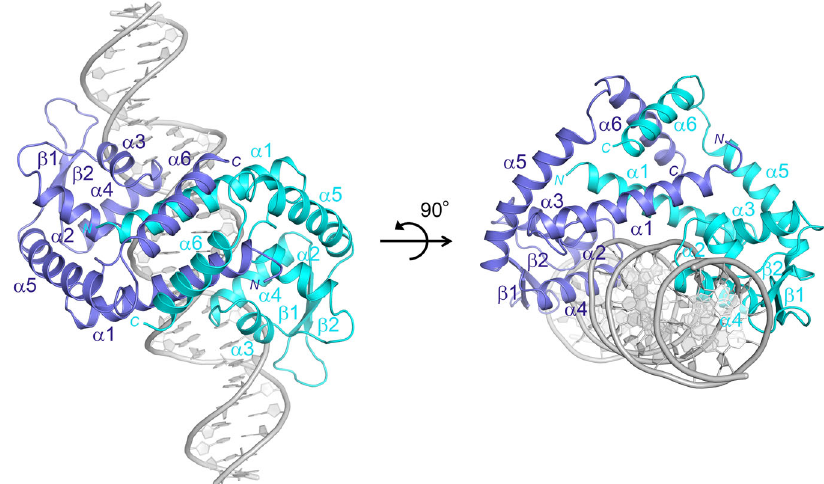
Fig. 2 Crystal structure of the apo-PefR – DNA complex. Overall structure of apo-PefR in the homodimer is represented by a ribbon model using blue and cyan for each subunit. The double-stranded DNA is shown in gray.